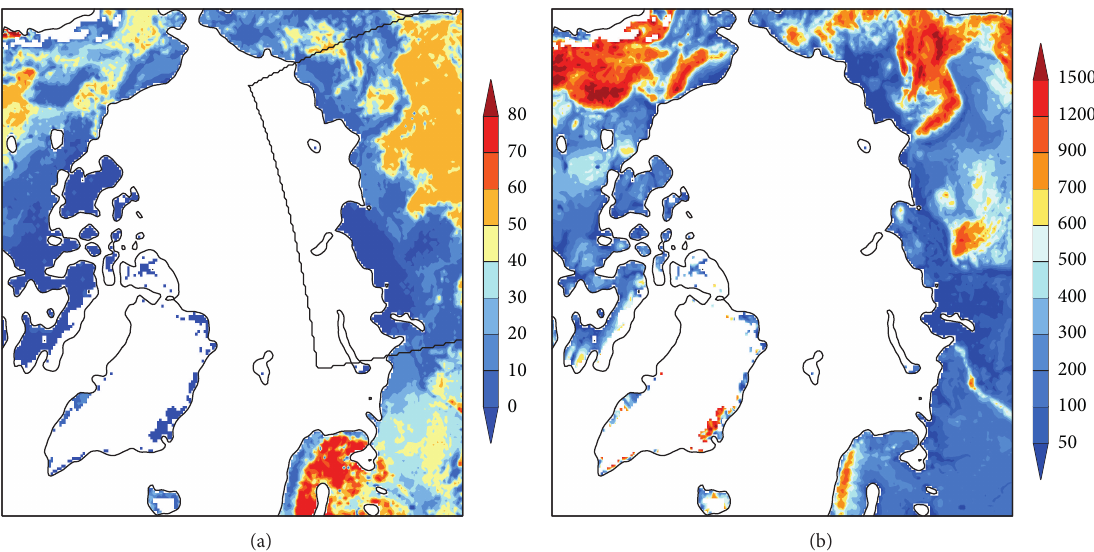
Figure 1: HIRHAM5 integration domain (ocean and glacier are excluded) and applied (a) forest fraction (%) and (b) orography (m). The black window in (a) indicate the Siberian